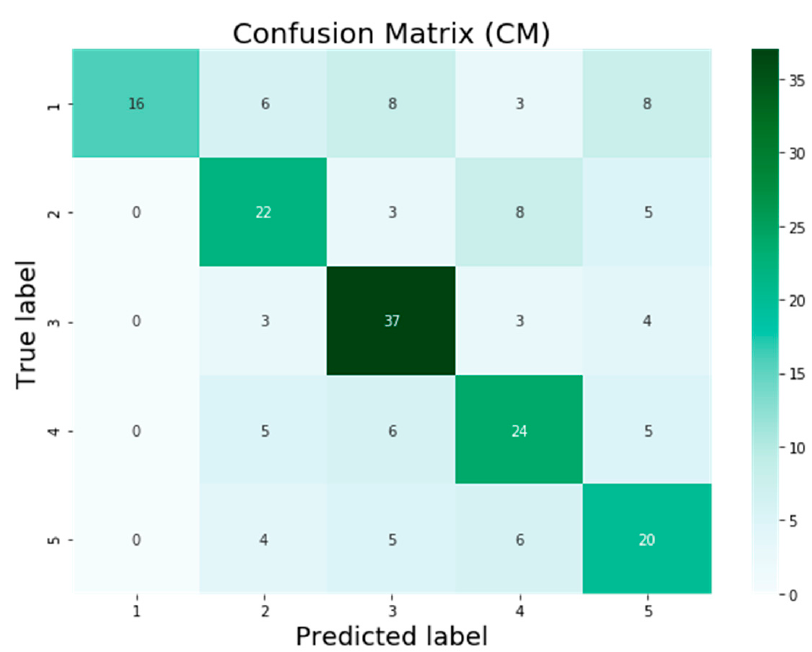
Figure 8. Confusion matrix (VGG16).